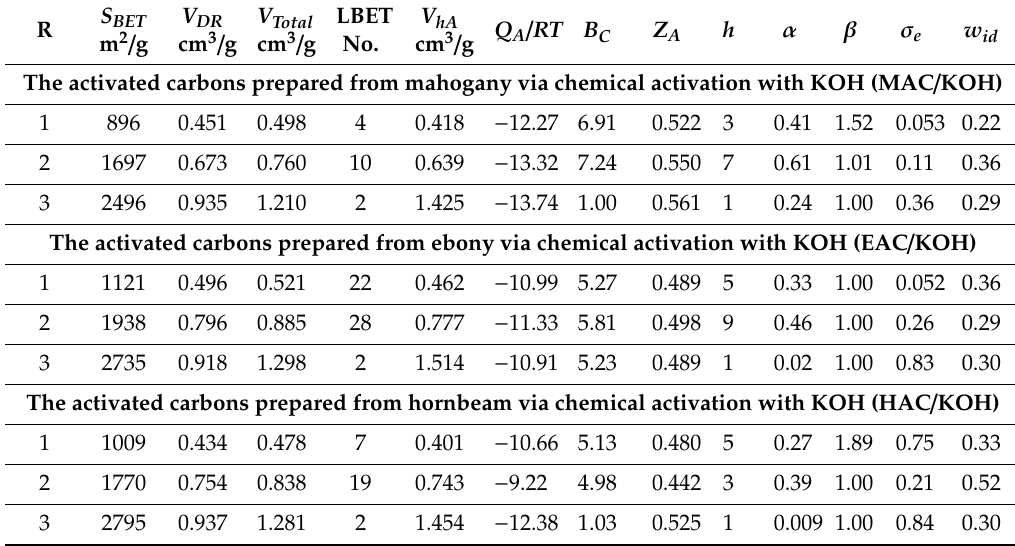
Table 1. The microporous structure of activated carbons based on nitrogen adsorption isotherms, determined using the Brunauer–Emmett–Teller (BET), Dubinin-Radushkevitch (DR), and numerical clustering-based adsorption analysis (LBET)